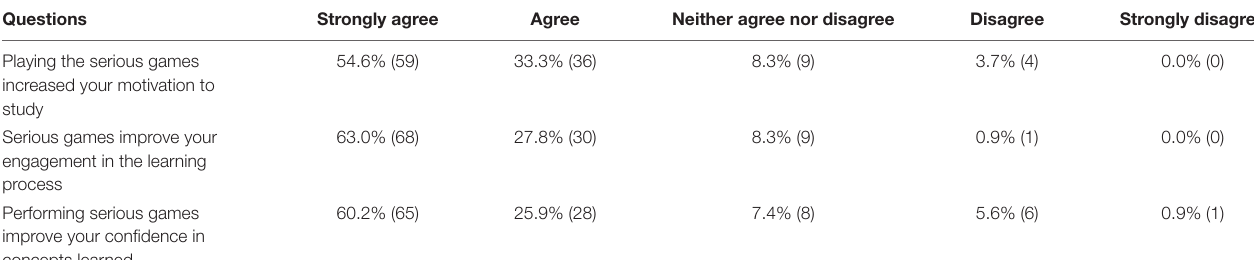
TABLE 1 | Percentage of responses to questions on attitudinal